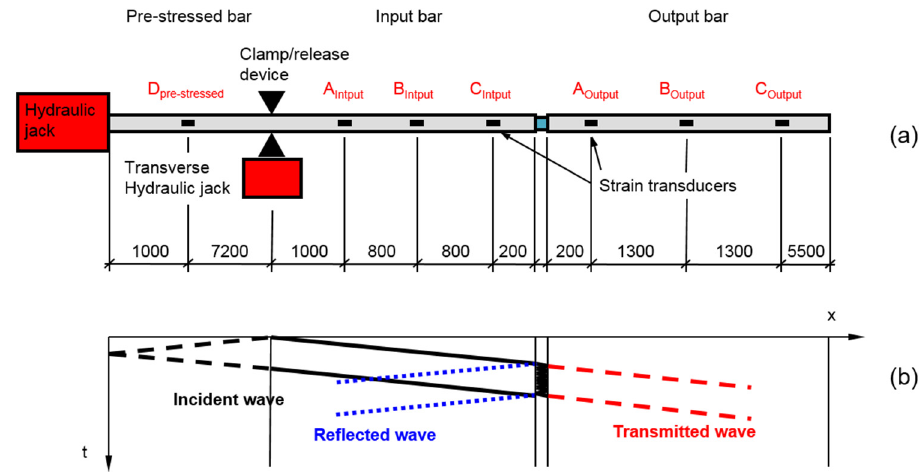
Figure 1. ( a ) Sketch not to scale of Modified Hopkinson Pressure Bar (dimensions in mm); and ( b ) related Lagrangian wave propagation diagram.